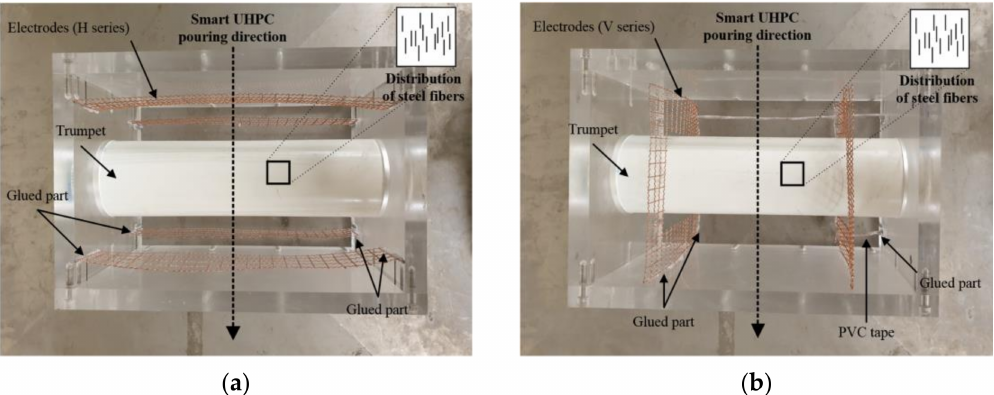
Figure 6. The setup of acrylic molds for casting the SCA: ( a ) H series; ( b ) V